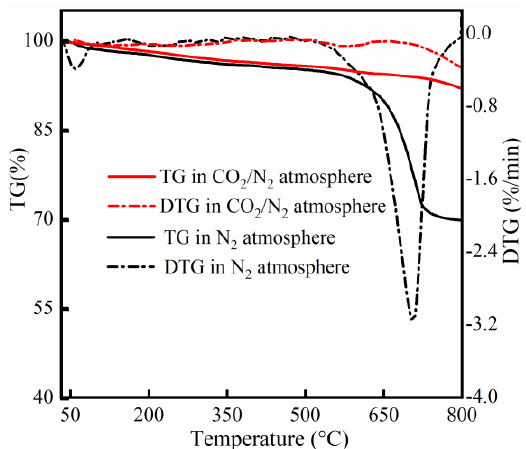
Figure 4. TG profiles of CaMgAl-LDOs in a 6% CO 2 /N 2 and N 2 atmosphere.